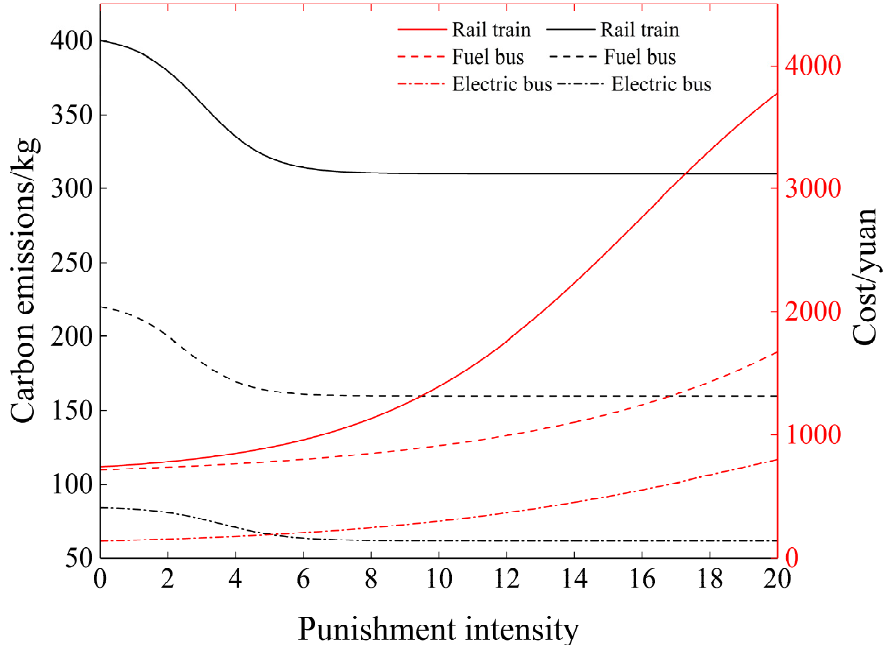
Figure 4. Changes in carbon emissions and costs of urban public transport vehicles under different penalties.